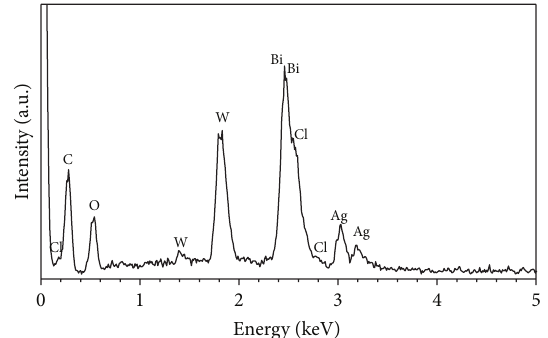
Figure 5: EDS of Ag/AgCl (10wt%)-Bi 2 WO 6 composite.